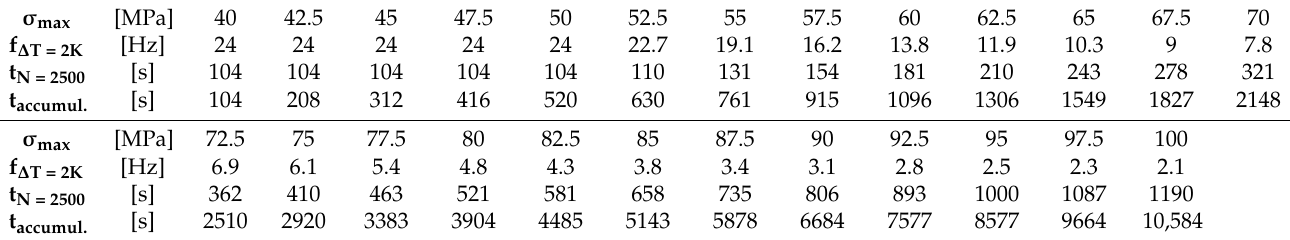
Table 4. Calculated frequencies for fatigue loads at given σ max with ∆ T up to 2 K according to Equation (1). Test duration shown for multiple amplitude test steps with length of 2500 cycles, individually and accumulated over test steps. σ